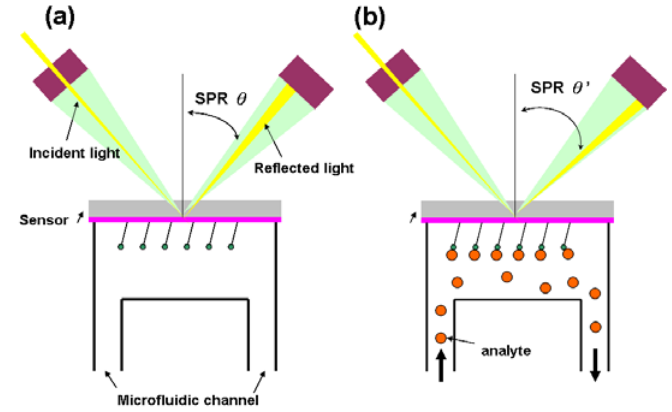
Figure 4. Schematic representation of a SPR biosensor (adapted from